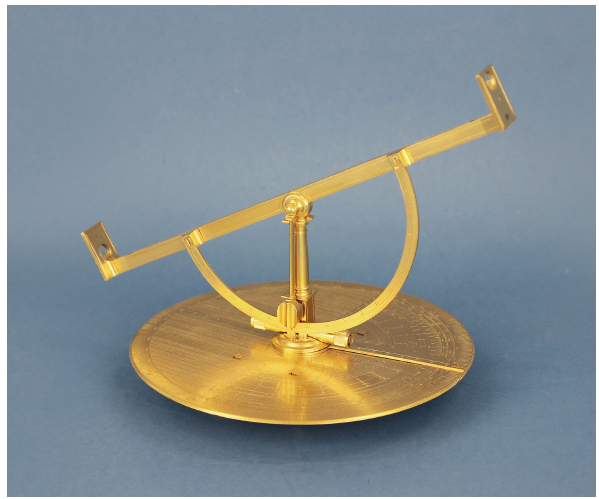
Figure 1. Theodolite by Stolle (photo supplied by https://www. surveyinginstruments.org, last access: 21 September